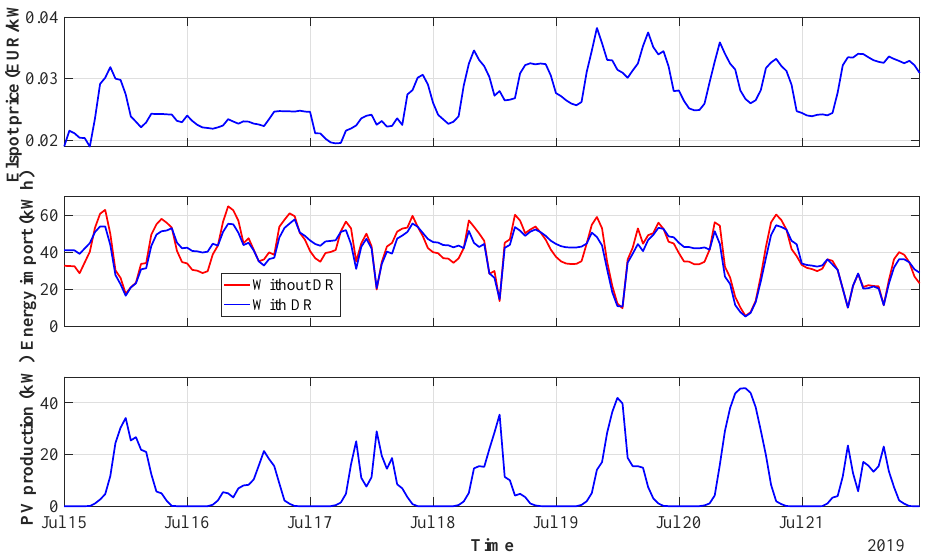
Figure 9. Elspot prices, energy import, and PV production.